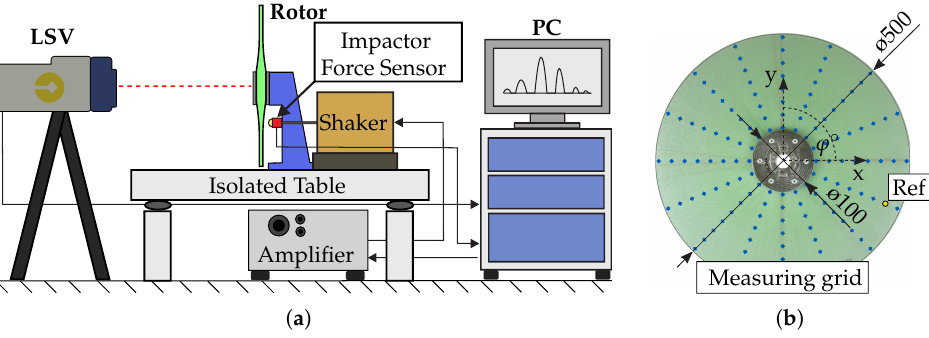
Figure 8. ( a ) Schematic set-up of the measuring equipment used in experimental modal analysis according to [5] and ( b ) rotor with measuring grid and